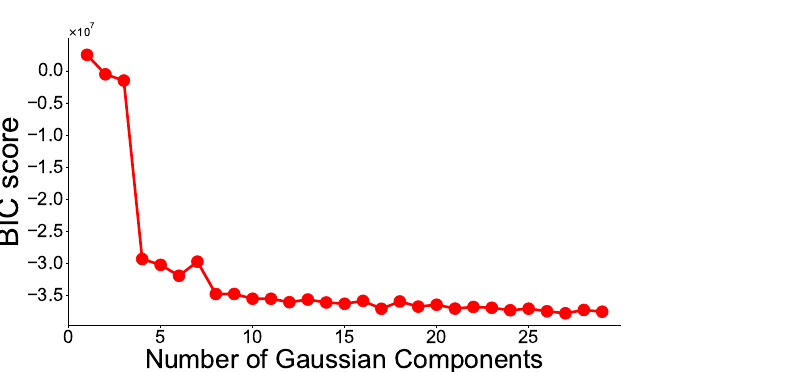
Figure 6. BIC Score with respect to the number of Gaussians components on the training dataset.